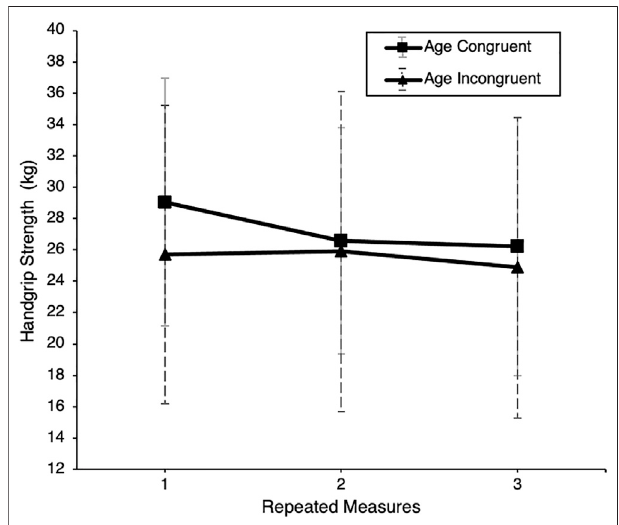
FIGURE 4 | Handgrip strength by experimental condition. Note. Handgrip-strength scores for young sample in kg of YA y (young avatar) and OA y (older avatar) subgroups over three repeated